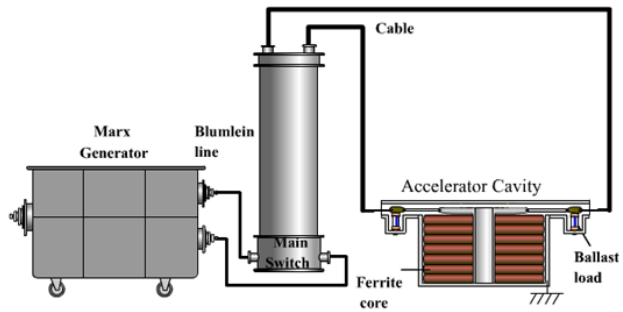
FIG. 2. (Color) Single module prototype of the pulsed-power